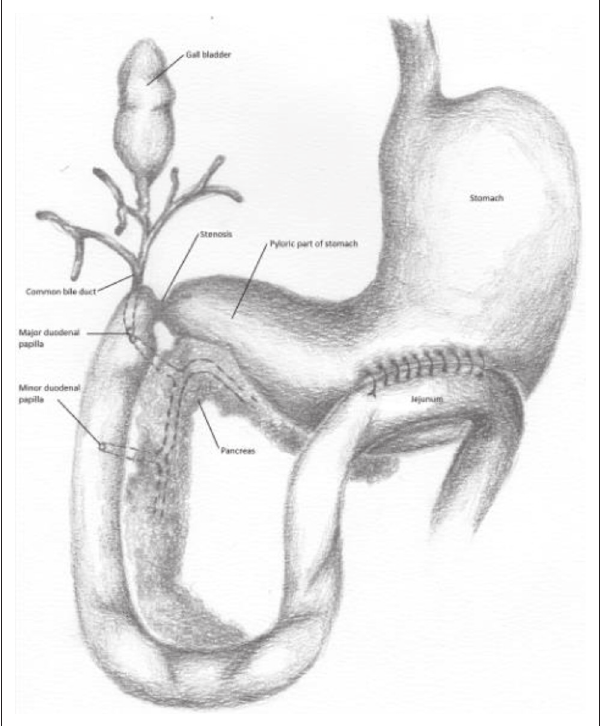
Source : L. Liebenberg, Fourways Veterinary Hospital, Bryanston, South Africa Figure 1: Schematic representation of the stomach, duodenum and proximal jejunum, indicating area of stenosis and area of